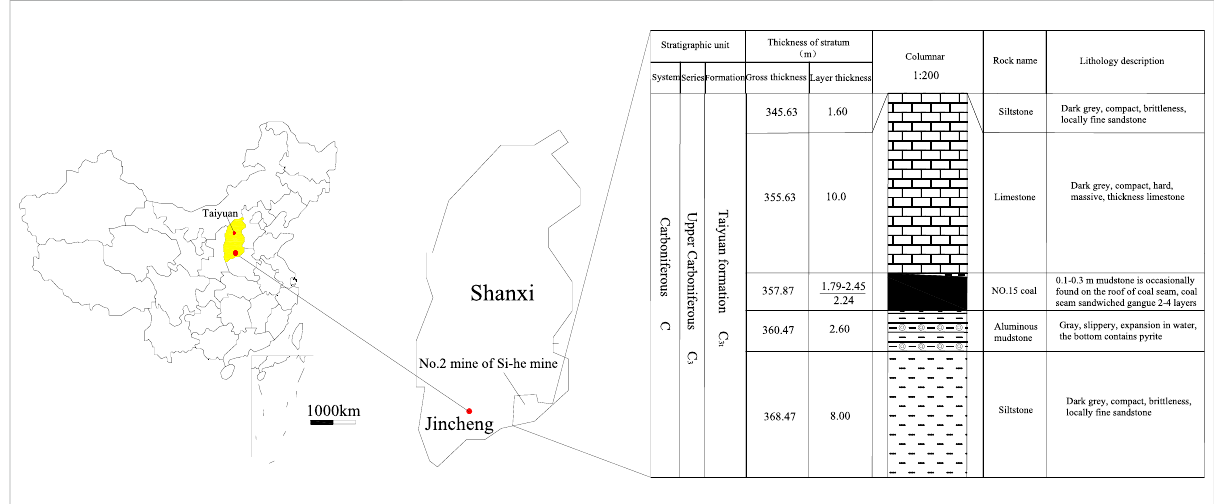
FIGURE 3 Location and stratigraphic structure of the main mining seam of No. 2 Well of Sihe Coal